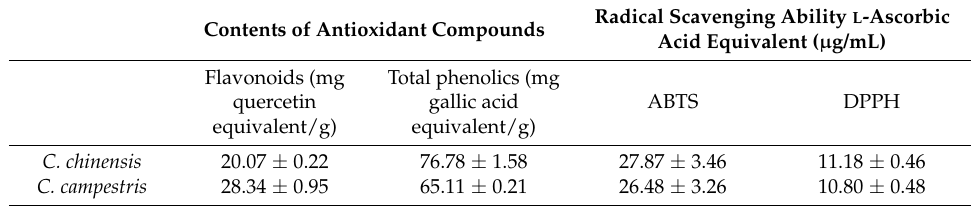
Table 1. The contents of total flavonoids and total phenolic compounds in the Cuscuta chinensis or C. campestris extract and their ABTS antioxidant capacity and DPPH scavenging